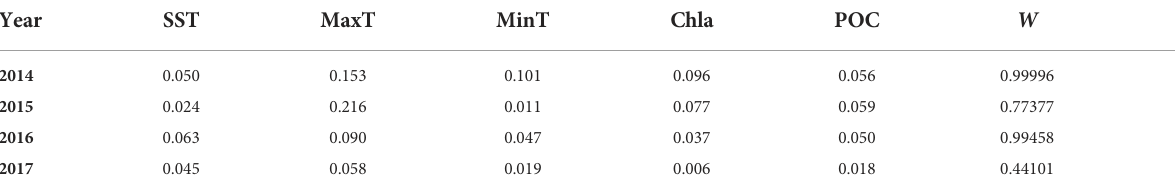
TABLE 5 Summary of the DISTLM analyses that investigated the relationship between multivariate pattern for sessile species and environmental variables (see Materials and Methods for details). For brevity, we report the relevant statistics for the best model for each year (the one with the lowest AICc value), which always included the fi ve measured environmental variables. The cells for each variable in the table indicate the squared semipartial correlation coef fi cient for each year. The weight of evidence for each model is indicated as W . The amount of variation in the response variable explained by each model is indicated with R 2 ( P < 0.001 in all cases).